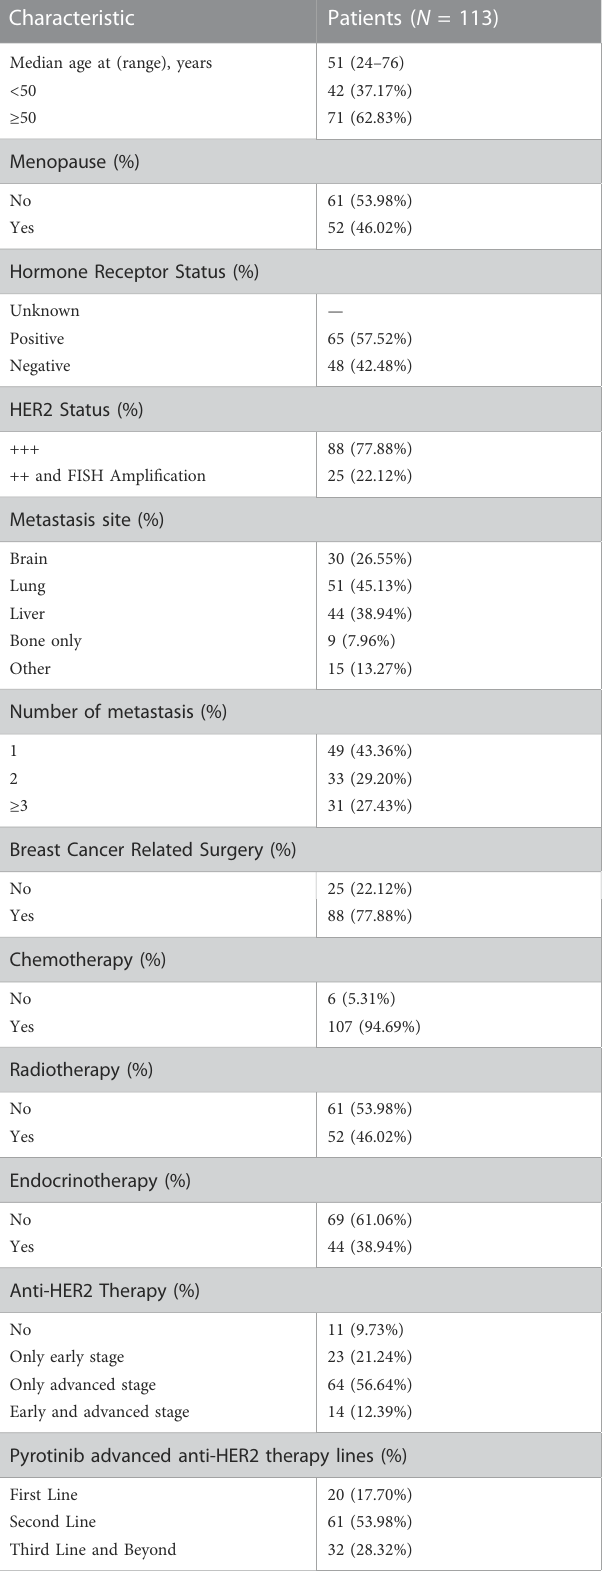
TABLE 1 The baseline characteristics of the 113 enrolled patients.